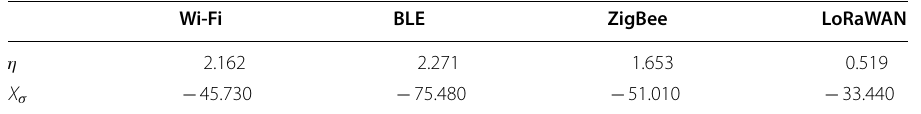
Table 2 Parameters used in environment 2